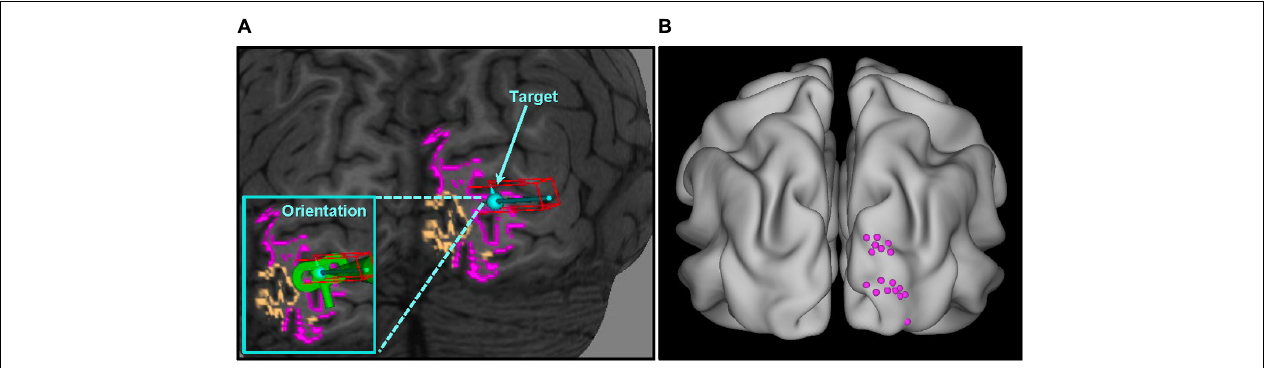
FIGURE 2 | V2 localization overview. (A) Target selection for a single representative subject. Individualized overlays were superimposed on the T1 anatomical image (native space) – V1 colored orange, V2 colored pink – and used as guides in the V2 localization process; (B) V2 targets for all participants standardized in MNI space (average location: x = 21 ± 5, y = –95 ± 6, z = 19 ± 12; see Supplementary Material for individual subject coordinates). V1, primary visual cortex; V2, secondary visual